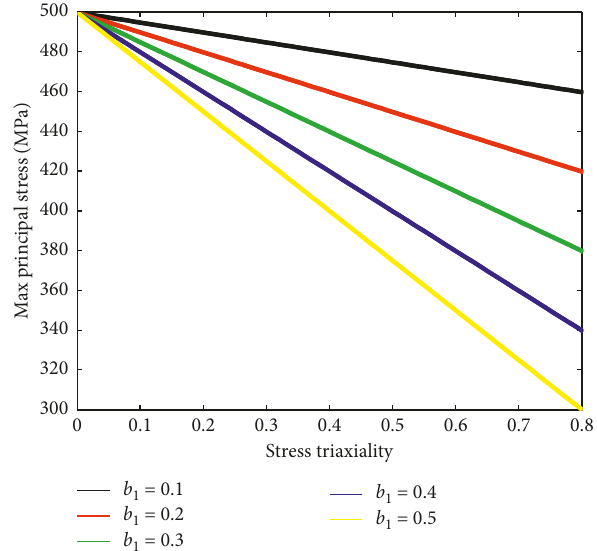
Figure 2: Effect of b 1 in the space of the stress triaxiality and maximal principal stress.